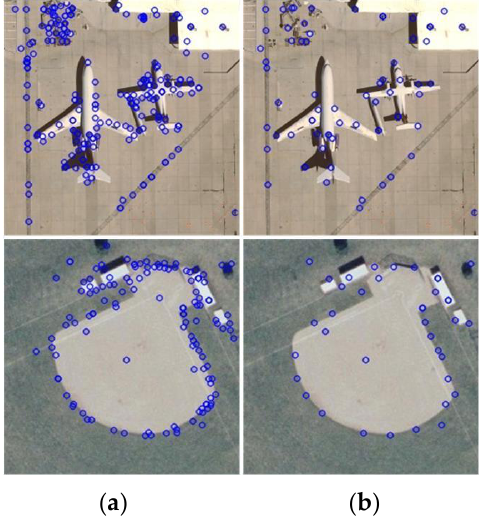
Figure 1. ( a ) Original Scale-Invariant Feature Transform (SIFT) features extracted from images ( b ) keypoint selection results using modified keypoint selection method presented in this text.